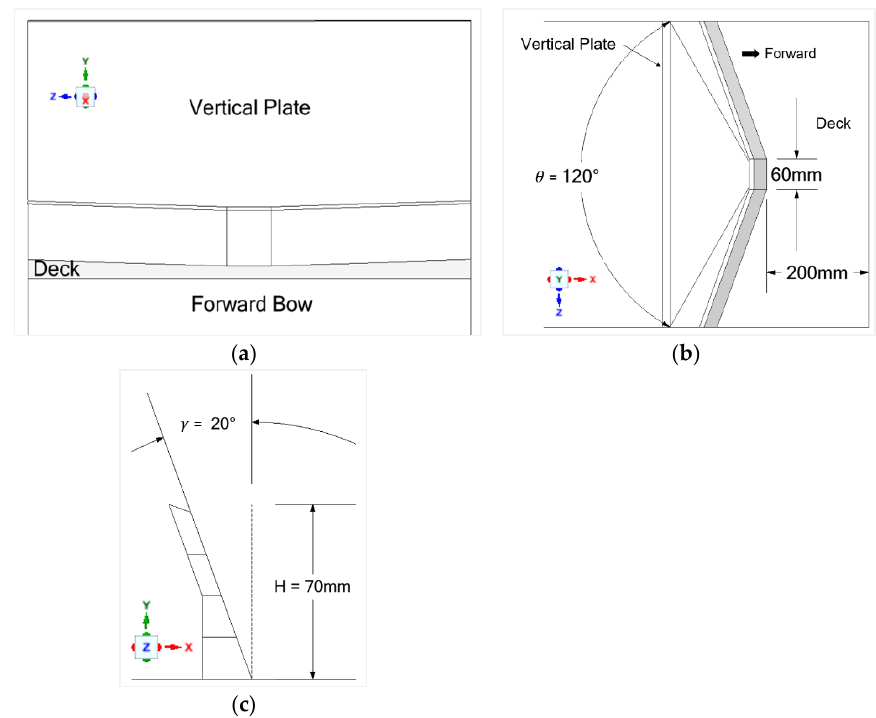
Figure 5. Design of windshield breakwater: ( a ) front view; ( b ) top view; ( c ) side view.